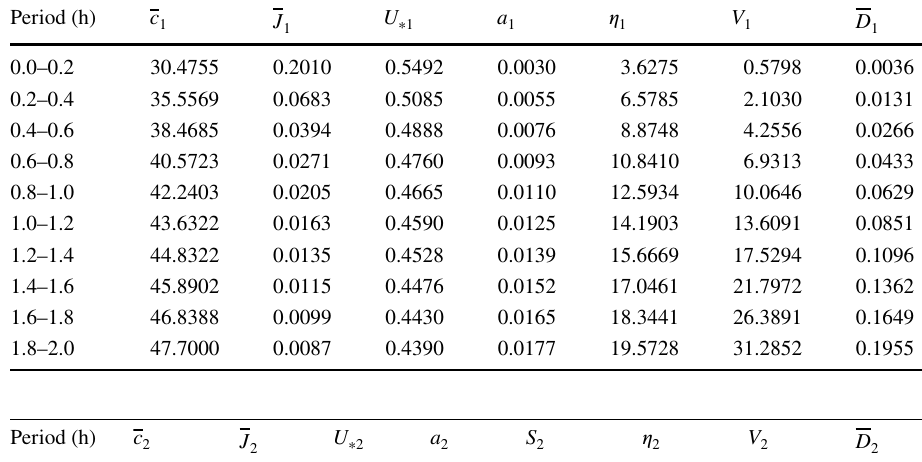
Table 4 Hydraulic parameters, sediment settling rates and average siltation thickness values of the second calculation segment